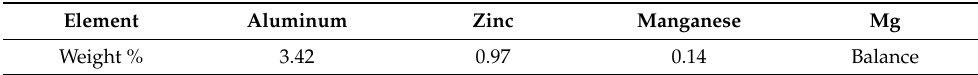
Table 2. Chemical composition of AZ31C mg